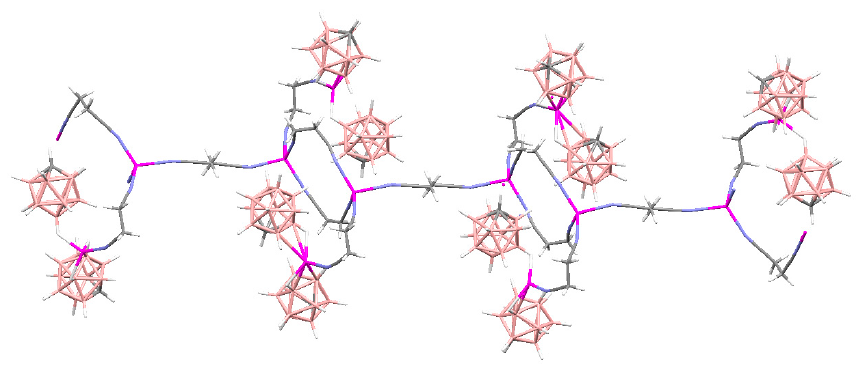
Figure 86. The coordination sphere of the Ag atoms ( a ) and crystal packing ( b ) in the structure of